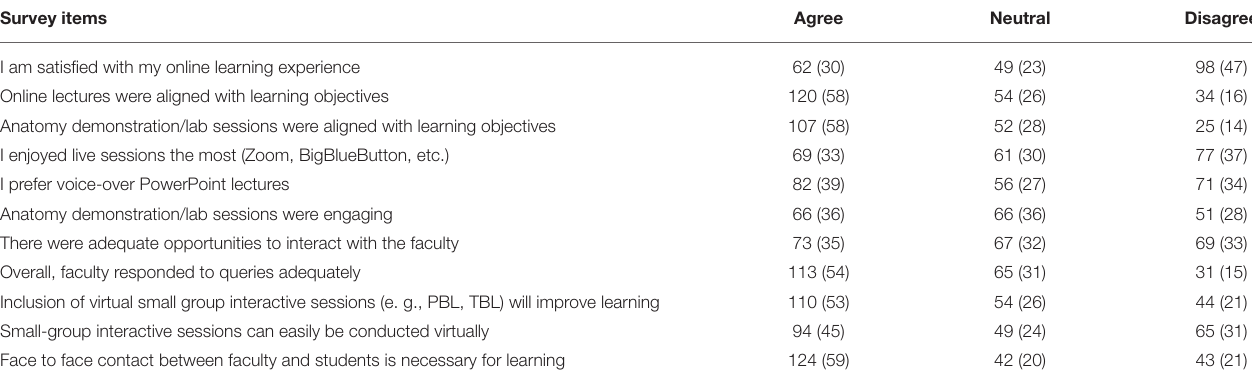
TABLE 2 | Perception regarding online learning experience based on the Likert scale responses ( N = 209) * .